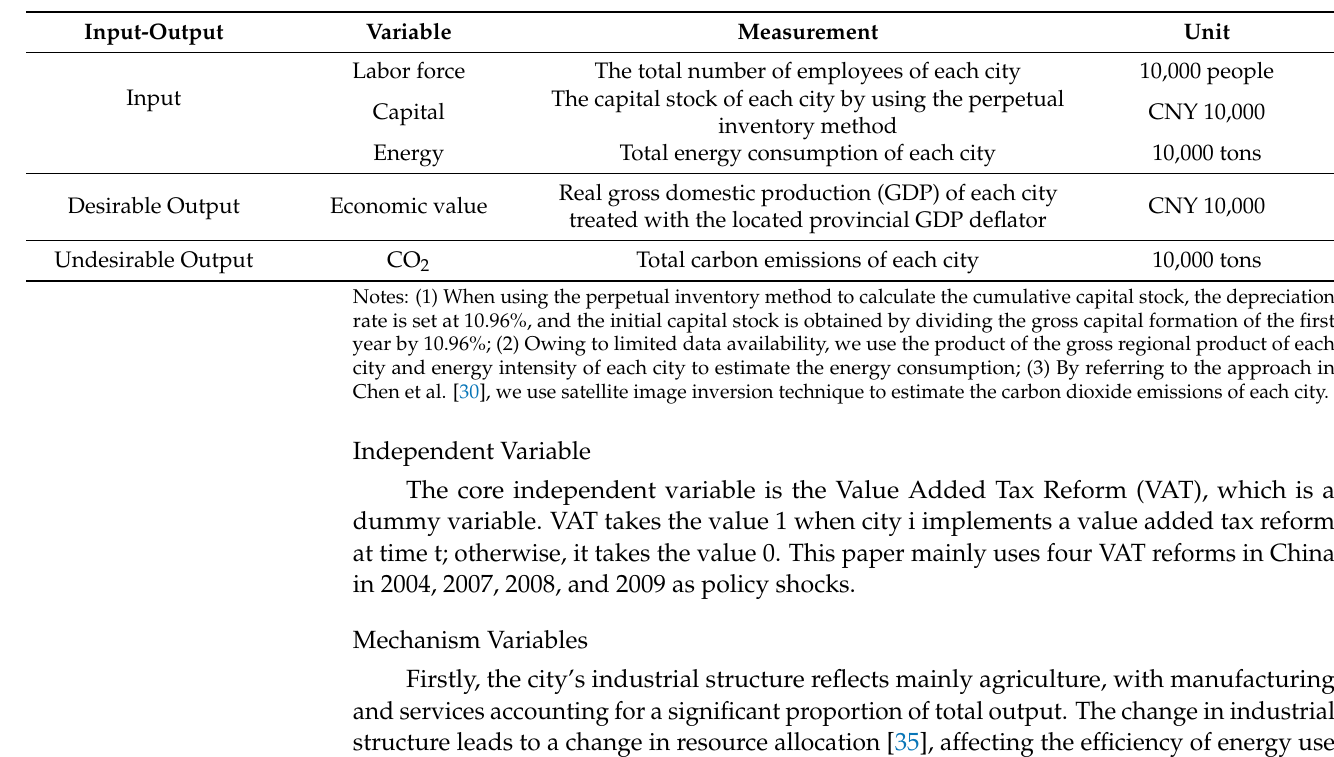
Table 2. Input and output variables for evaluating the